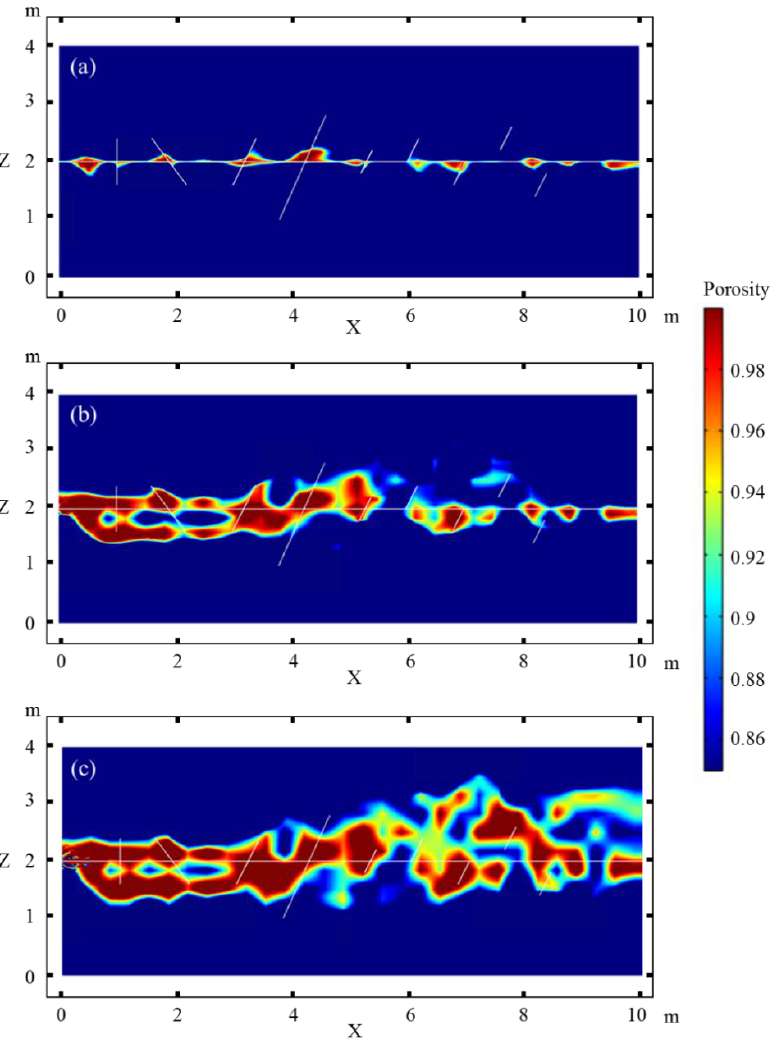
Figure 6. Effect of the matrix porosity on the dissolution with intersecting fractures. The matrix permeability factor C K in ( a ), ( b ), and ( c ) is 1 × 10 −13 , 1 × 10 −12 , and 1 × 10 −11 m 2 , respectively. permeability factor C K in ( a ), ( b ), and ( c ) is 1 × 10 − 13 , 1 × 10 − 12 , and 1 × 10 − 11 m 2 ,